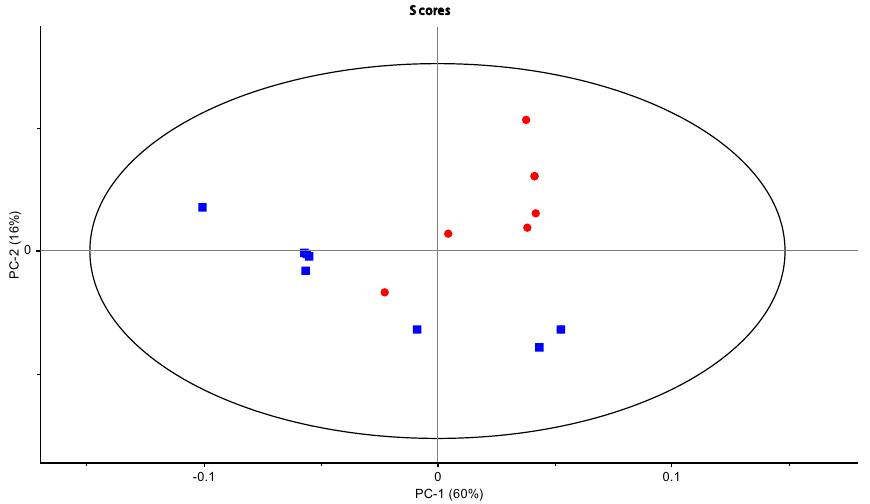
Figure 1. PCA scores plot for Mycoplasma fermentans (8 biofilm red filled circle and 8 planktonic blue filled square samples) from 1D 1 H NMR analysis of